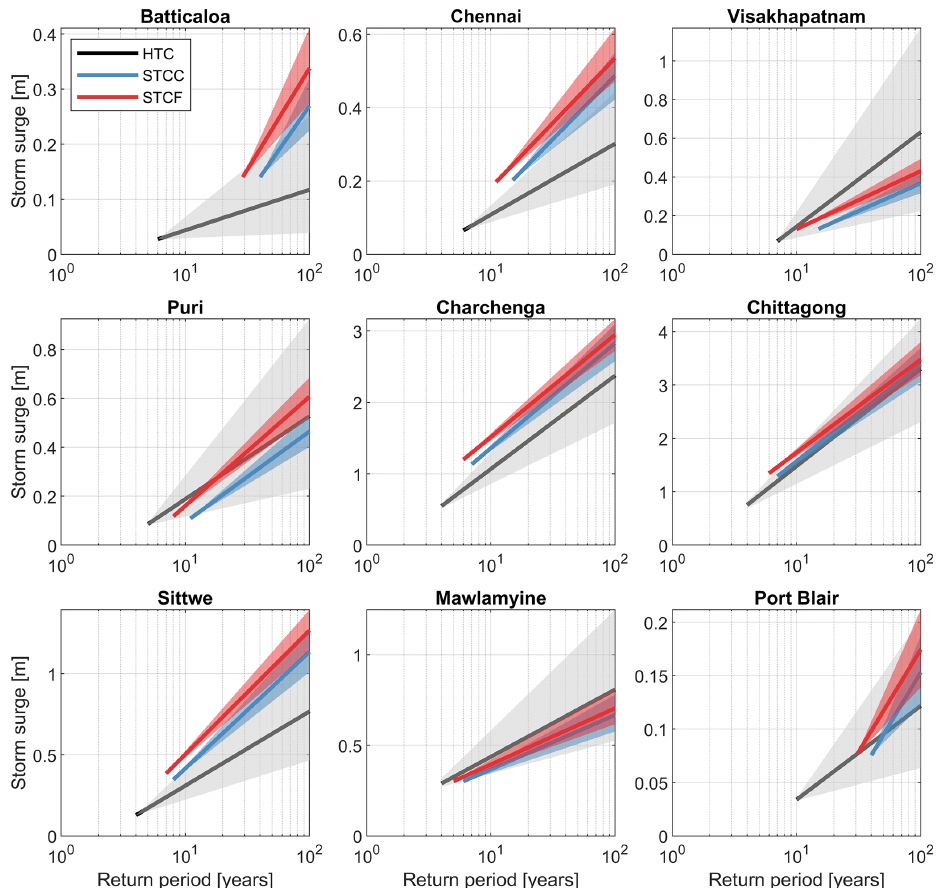
Figure 10. Extreme value analysis for nine different locations for storm surge based on HTCs (black), STCC (blue) and STCF (red). Per panel both the fit (solid line) and 95% confidence intervals (background fill) are included. The horizontal axis is the return period on a logarithmic scale, and the vertical axis is storm surge in meters. Note the orientation of locations goes in a clockwise direction through the Bay of Bengal from Batticaloa to Port Blair and the y axis varies per